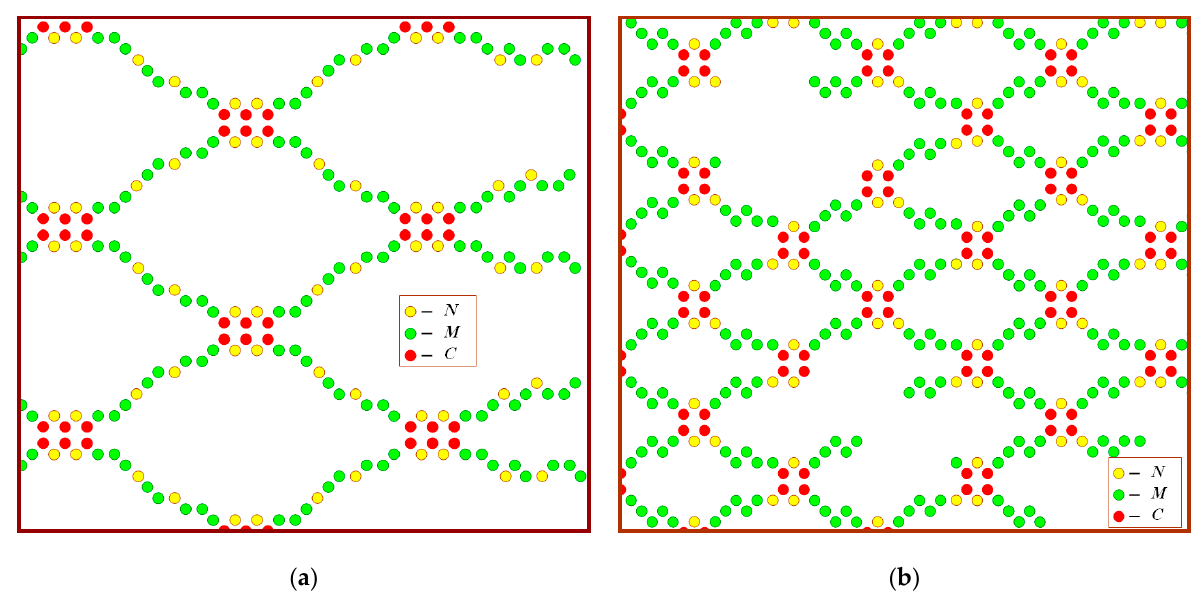
Figure 5. Mesh structure of pectin: ( a ) Р Rh sample; ( b ) Р Ct sample.